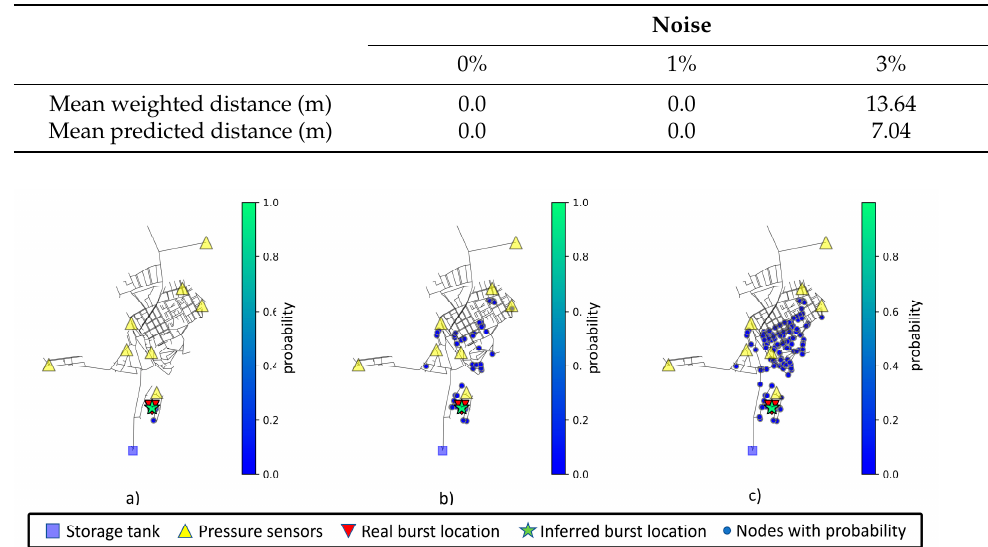
Figure 11. Network prediction areas for node 40, considering ( a ) 0% noise level, ( b ) 1% noise level, and ( c ) 3% noise level. Nodes with higher probability are displayed in a greener color and with lower probability in a bluer color, following the scale presented to the right of each chart.